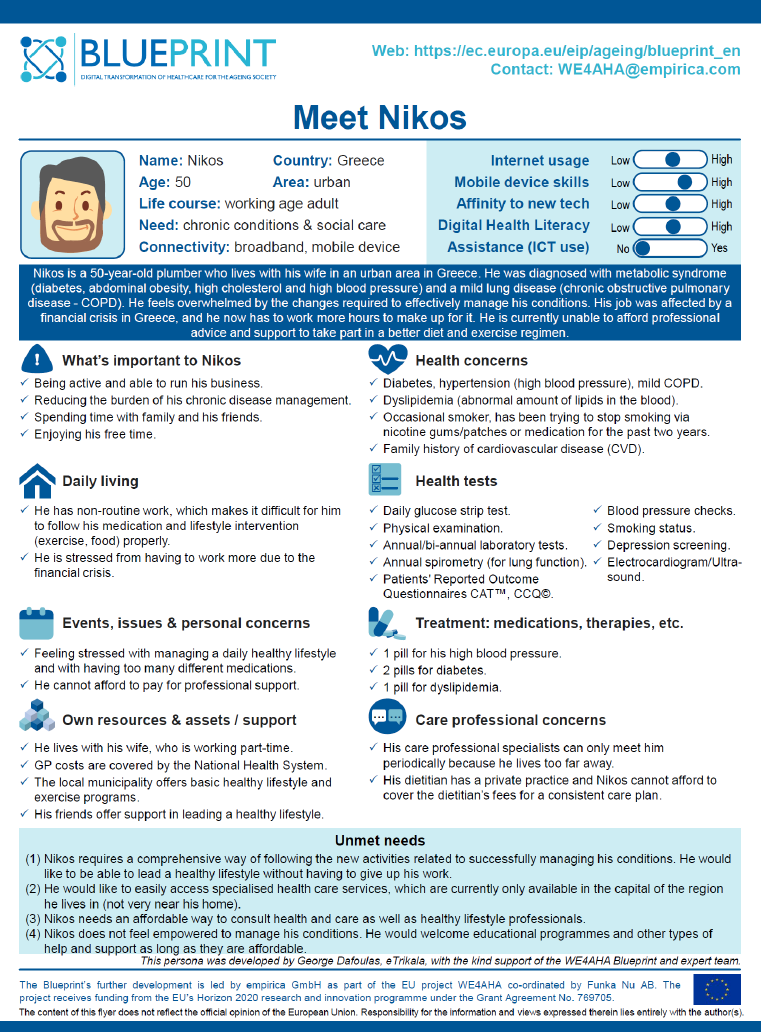
Figure 2. Nikos’ persona poster developed by Empirica GmbH, represents health and care needs, aspirations, attitudes, disease-related characteristics, of a chronic multimorbid patient, and